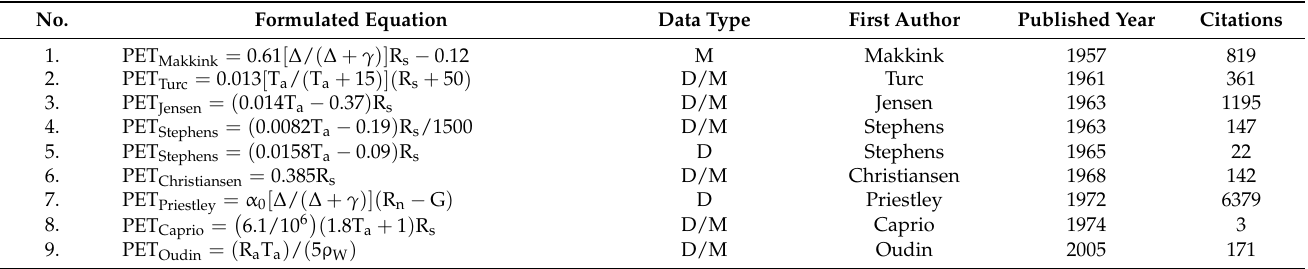
Table A2. PET radiation-based equations.